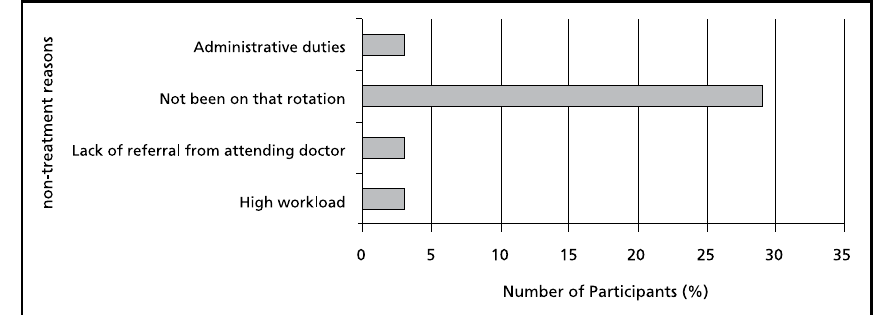
Figure 1: Reasons for not treating patients post-csD